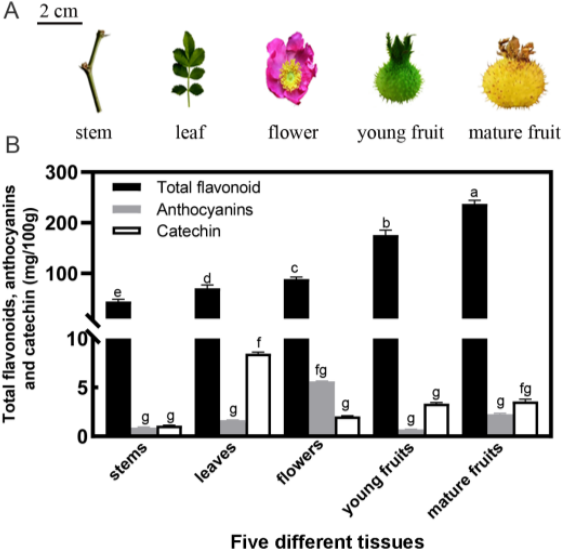
Figure 1. The amounts of total flavonoid, anthocyanin, and catechin in different tissues of R. roxburghii . ( A ) The phenotypes of five tissues. ( B ) The values of flavonoids. The horizontal axis indicates different tissues, including stems, leaves, flowers, young fruits, and mature fruits. The contents are expressed as mg/100 g of the fresh weight. The vertical bar represents the means ± standard deviation of three separate experiments. Different (One-way ANOVA followed by Turkey’s post hoc test) letters indicate significance in the expression levels at the 0.05 level.